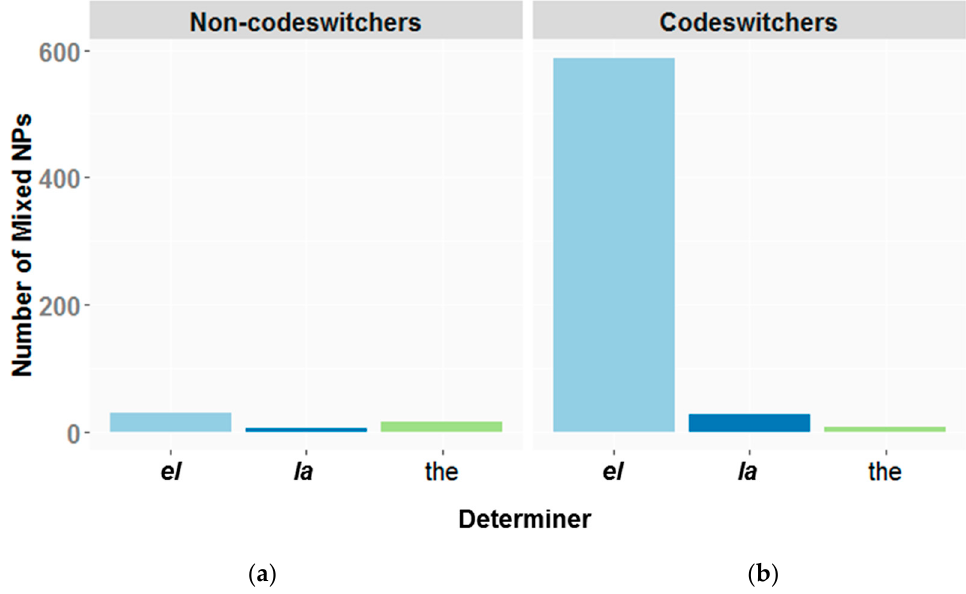
Figure 2. Distribution of mixed noun phrases (NPs) produced by ( a ) non-codeswitchers and ( b ) codeswitchers in Beatty-Martínez and Dussias (2017) Codeswitching Map Task.